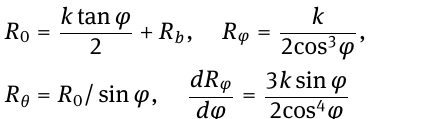
vaturein themeridionaland circumferentialdirectionsare respectively represented by R